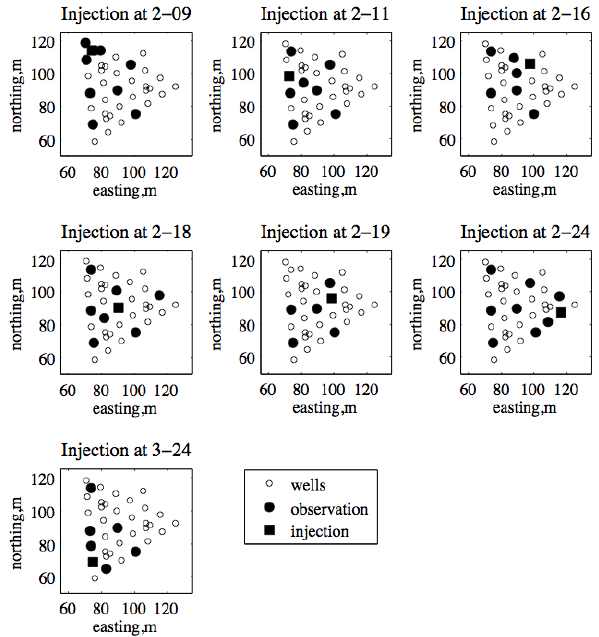
Fig. 2. Configuration of injection and observation wells in each test used in this paper. The reference point of local coordinates is at (594164m, 115976m) in the Hanford coordinates.